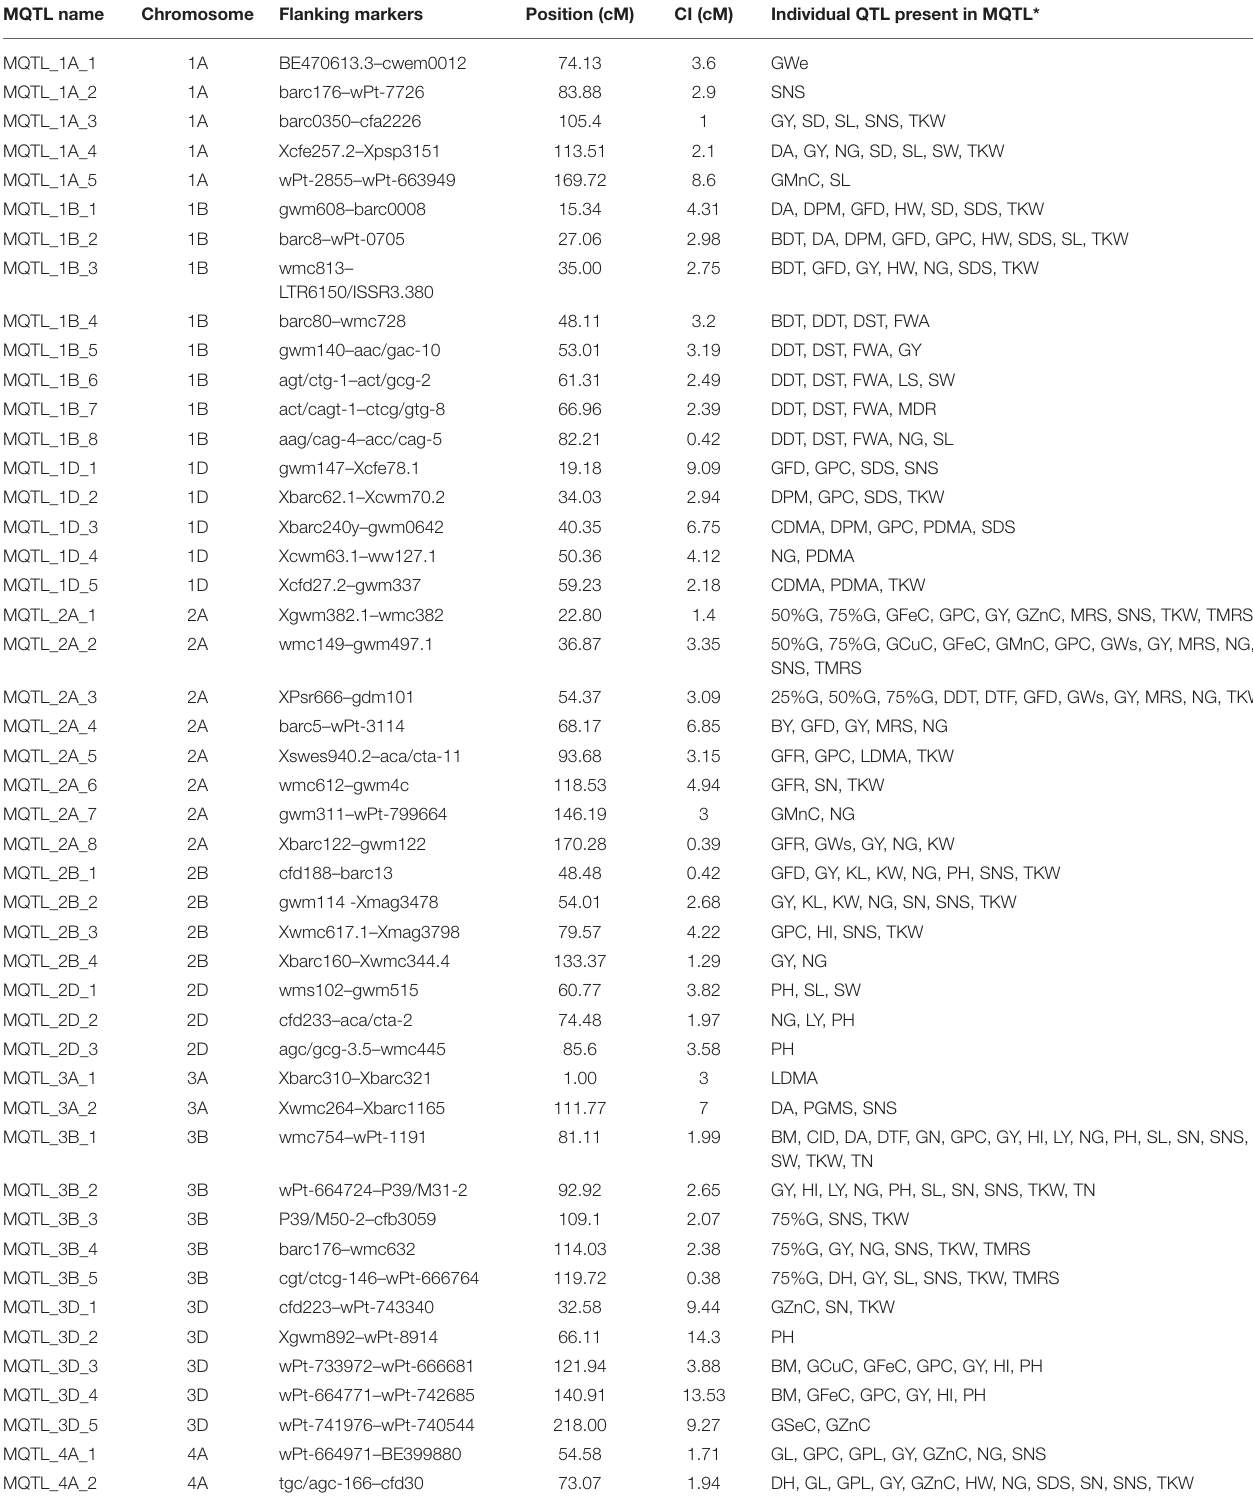
TABLE 2 | Description of detected meta-quantitative trait loci